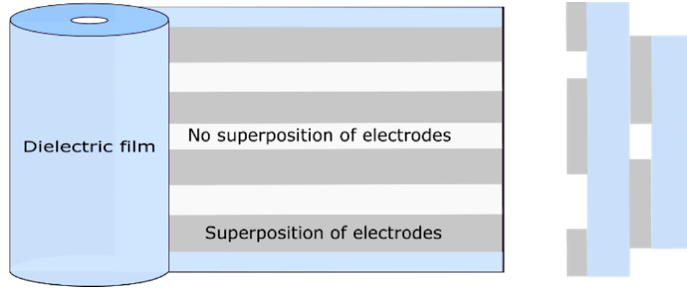
Figure 2. Metallized multisection capacitor [16].